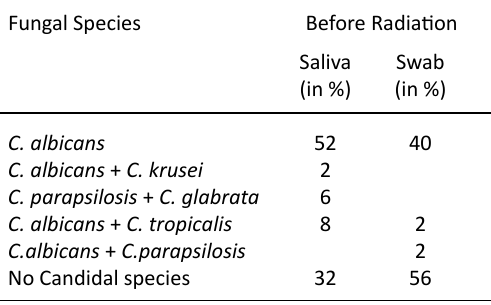
Table 1. Percentages of salivary and swab samples of oral cancer patients showing growth of different fungal